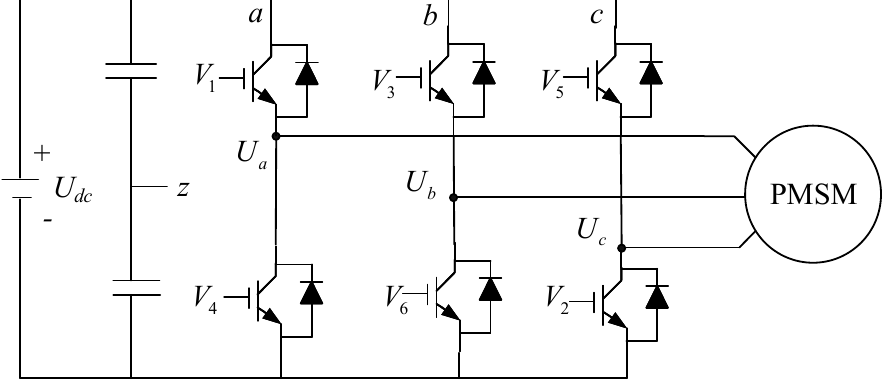
Figure 1. Typical topology of three-phase voltage source inverter.